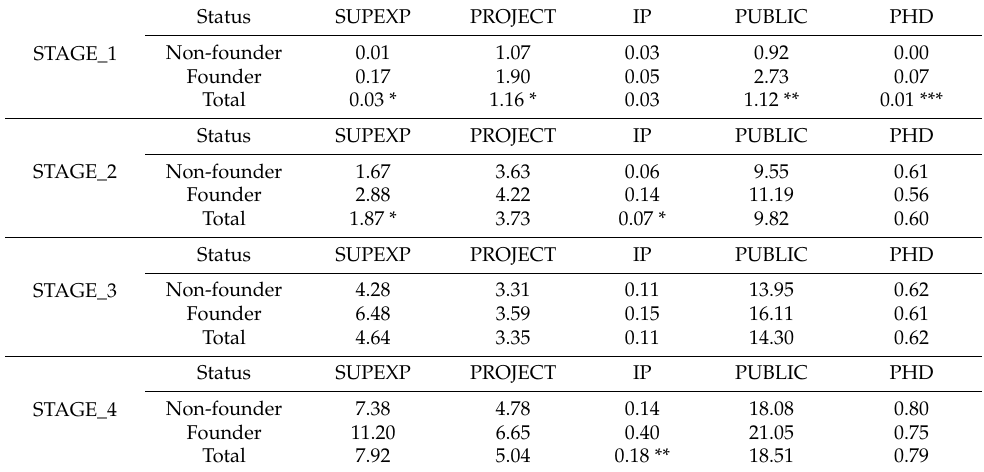
Table A1. Science workers’ means with statistical